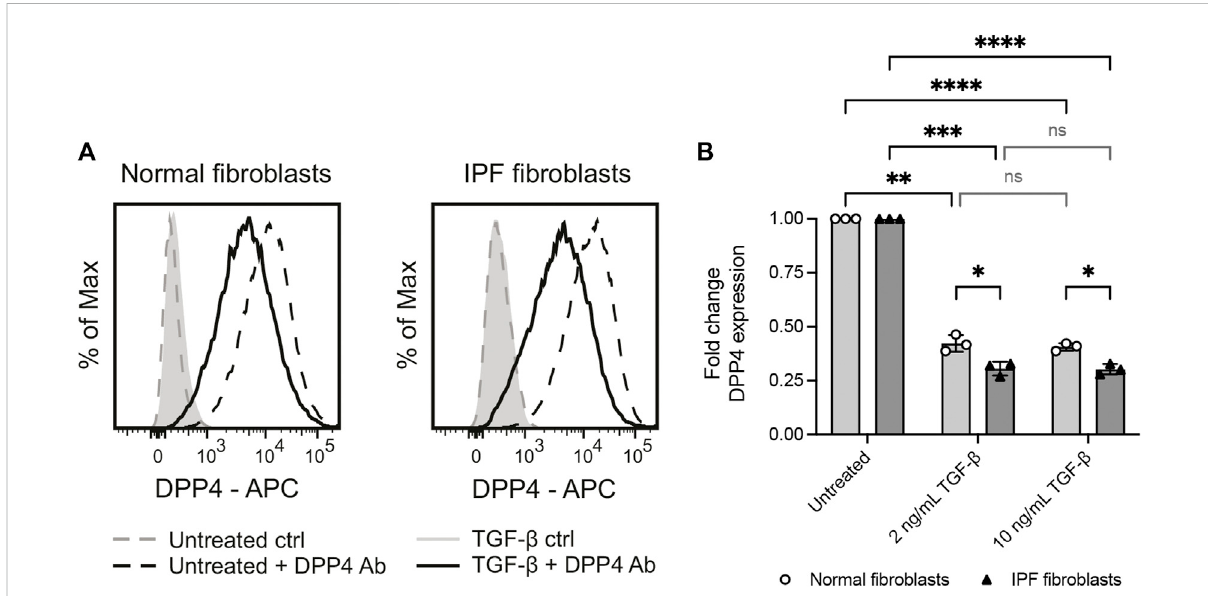
FIGURE 4 Pro fi brotic stimuli (TGF- β 1) reduce the levels of cell surface DPP4 on normal and IPF fi broblasts. (A) Histograms show expression of DPP4 measured by fl ow cytometry on cultured normal and IPF lung fi broblasts after 48 h with or without TGF- β 1 (2 ng/ml) supplemented media. Plotsshow dataafter forward/sidescattergating anddoubletdiscrimination. (B) FoldchangeDPP4expressioninlung fi broblastsfromnormal( n =3) or IPF ( n = 3) tissue treated with 2 ng/ml or 10 ng/ml TGF- β 1 for 48 h compared to untreated controls as measured by fl ow cytometry. Fold changes (normal untreated vs normal treated;IPF untreated vsIPF treated)are calculated fromdelta median fl uorescence intensity between stained and unstained cells. Bars represent mean (SD). For statistical analysis, a mixed-effects analysis with Tukey ’ s (within disease groups) and Š ídák ’ s (between disease groups) multiple comparisons test was used. * p < 0.05, ** p < 0.01, *** p < 0.001, **** p <